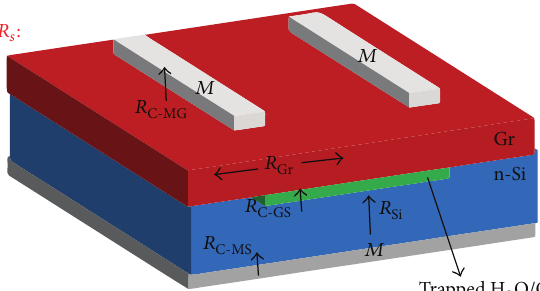
Figure 4: Schematic diagraph of the 𝑅 𝑠 compositions of Gr/Si solar cell. The resistance of the top metal electrode and that of the bottom metal electrode are ignored.